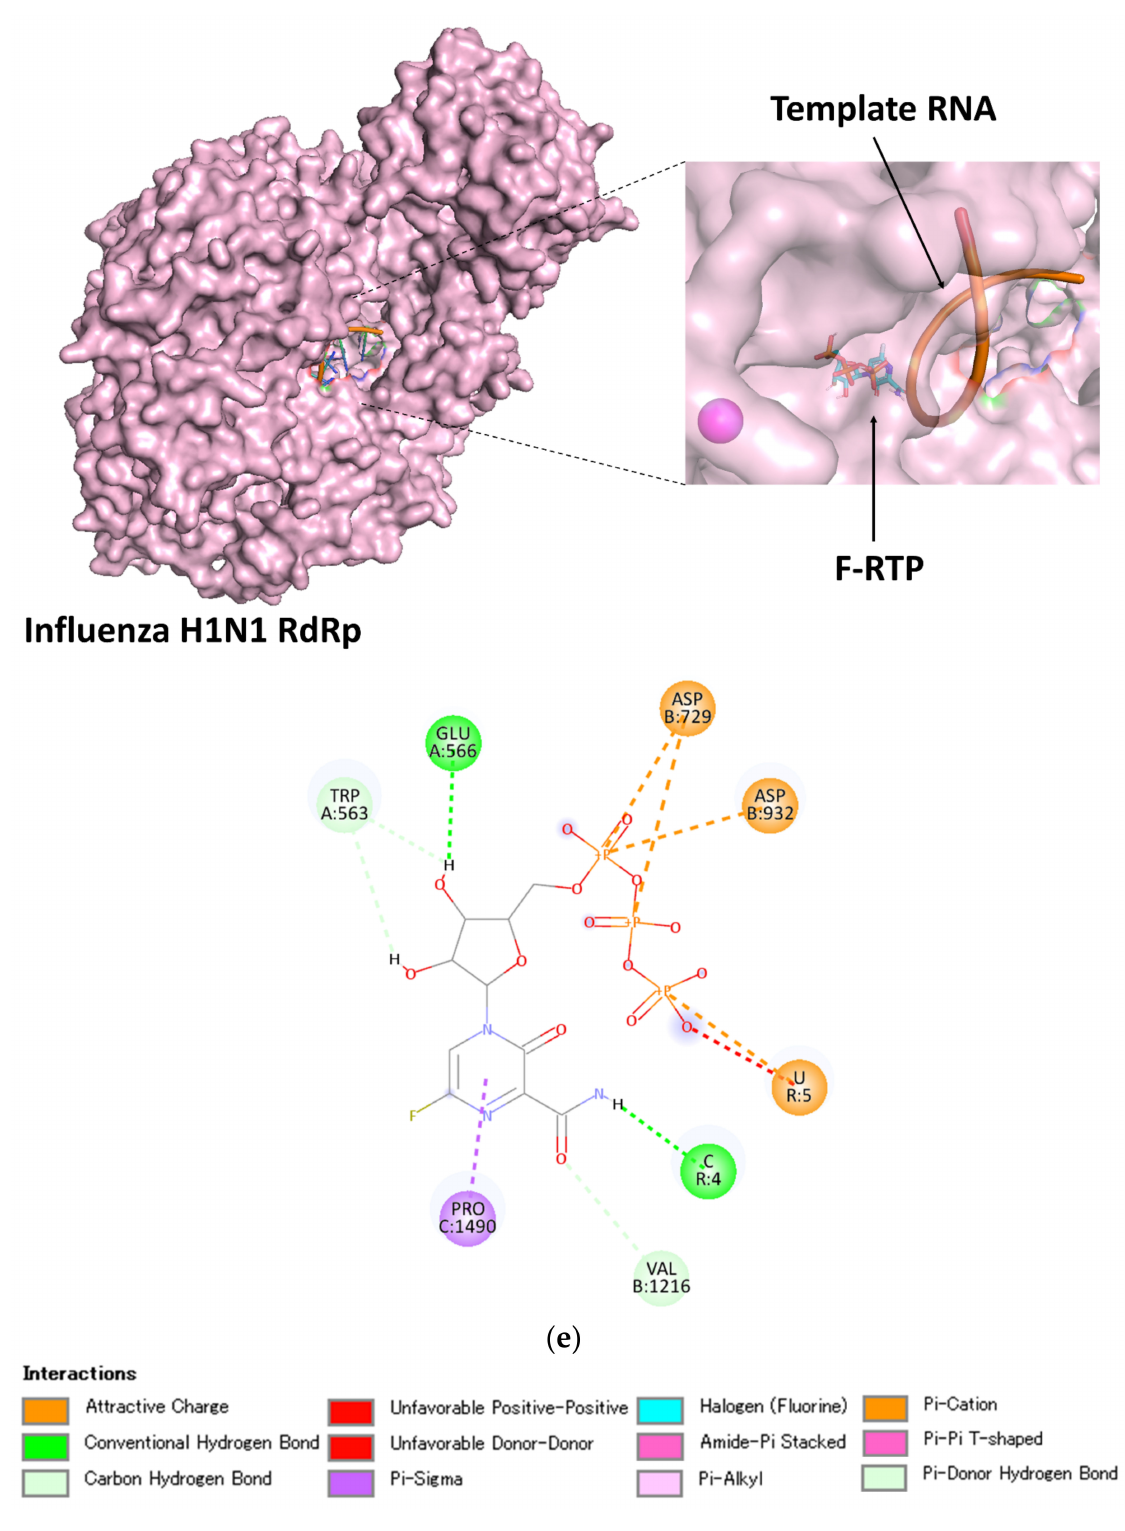
Figure 3. Diagram illustrating the binding conformations and interactions among favipiravir ribofuranosyl-5 (cid:48) -triphosphate (F-RTP), nucleotide triphosphate (NTP), magnesium ions, and ( a ) human metapneumovirus (HMPV) RNA-dependent RNA polymerase (RdRp), ( b ) respiratory syncytial virus (RSV) RdRp, ( c ) mumps virus (MuV) RdRp, ( d ) measles virus (MeV) RdRp, and ( e ) influenza H1N1 RdRp. The active sites on proteins are shown in red. Magnesium ions that bound to the RdRp are colored